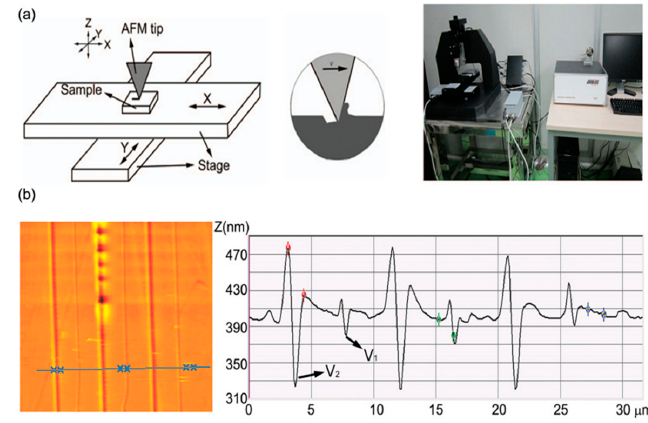
Figure 6. Schematic diagram of the formation process of nanodot arrays: ( a ) schematic of the modified AFM system with a large-scale rang of X-Y stage. ( b ) the morphology and cross-section image of typical nanoline arrays scratched by the above system [79] .